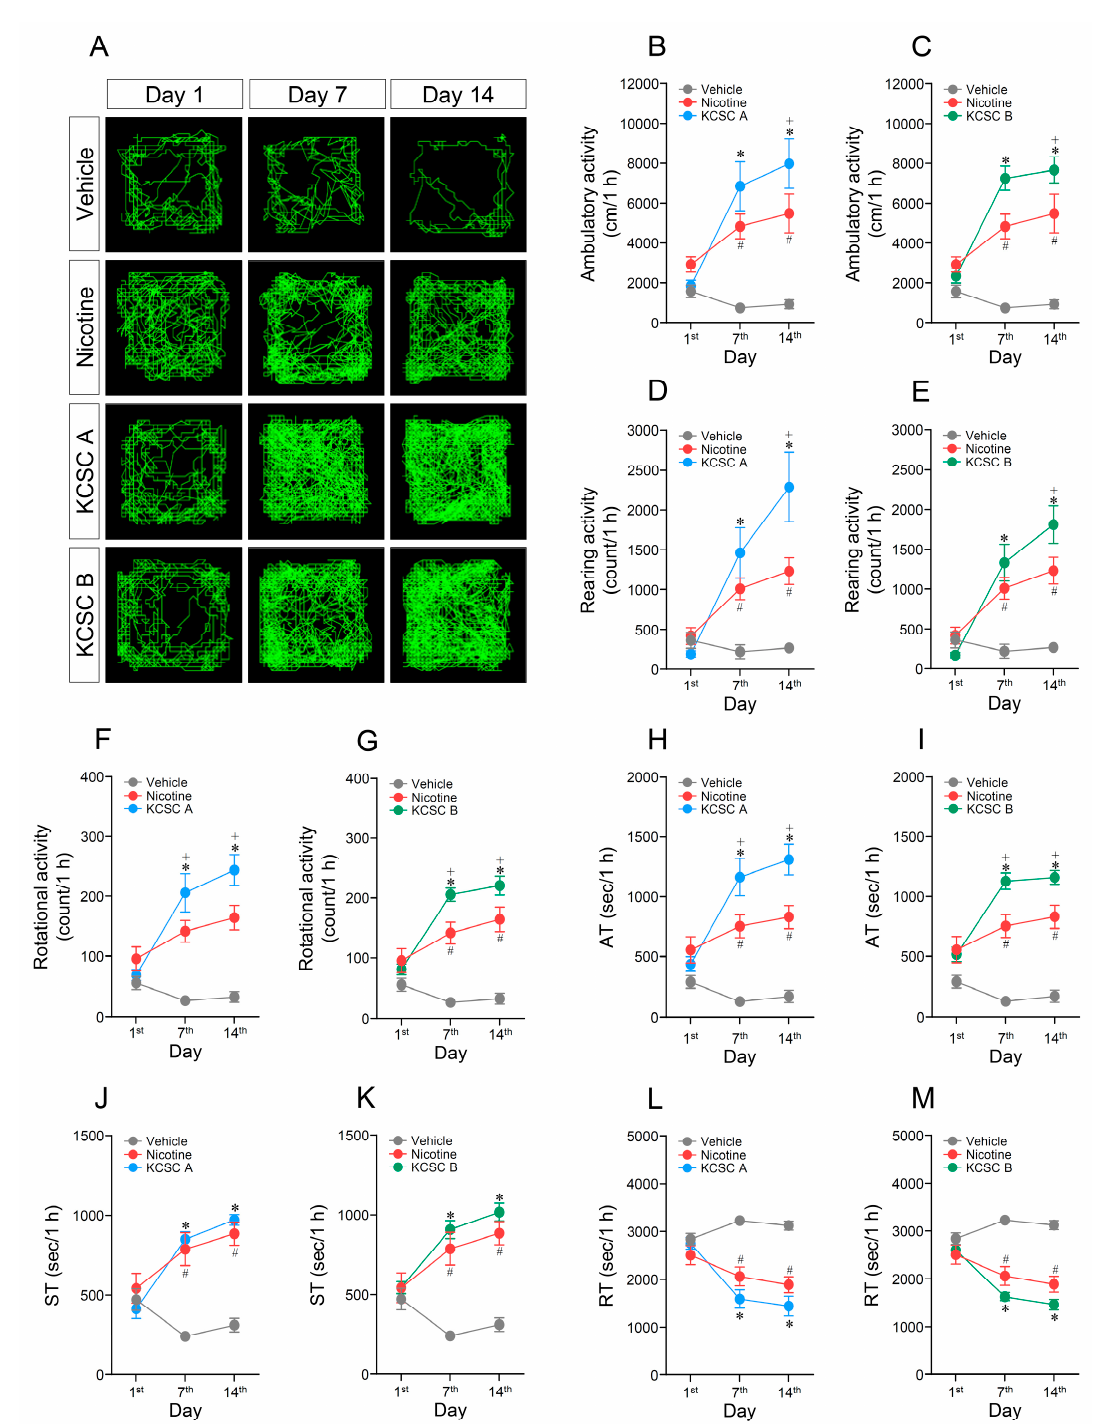
Figure 1. Changes in behavioral activities after acute or repeated administration of two cigarette smoke condensates extracted from two commercial cigarette brands in South Korea (KCSC A and KCSC B). Statistical significance was determined by two-way RM-ANOVA and multiple comparison test with Bonferroni’s post-hoc test. # p < 0.05, repeated vehicle group vs. repeated nicotine group; * p < 0.05, repeated vehicle group vs. repeated KCSC groups; + p < 0.05, repeated nicotine group vs. repeated KCSC groups. AT, ambulatory time; ST, stereotypy time; RT, resting time. n = 6 per group.